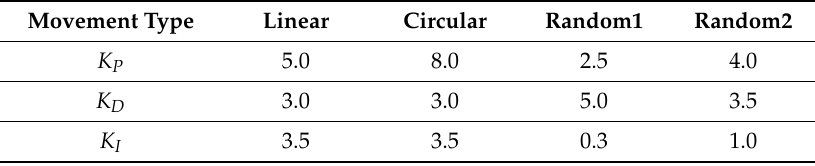
Table A1. Parameters of the Proportional-Integral-Derivative (PID)